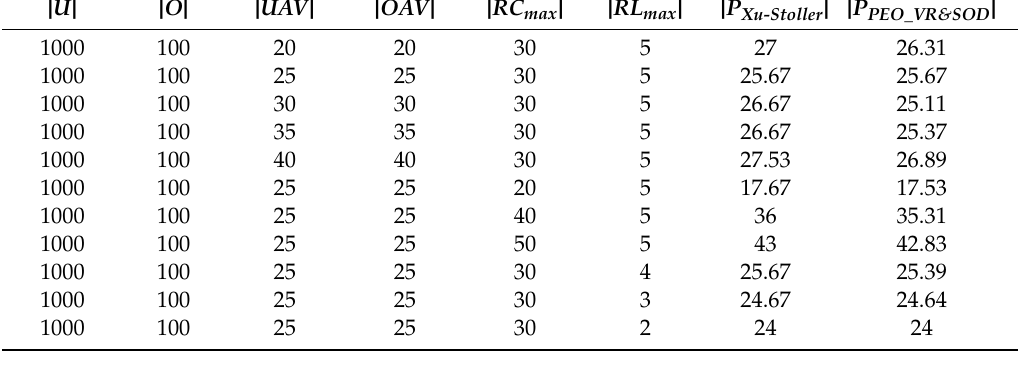
Figure 5. Comparison of time with Xu-Stoller for different numbers of attribute-value pairs.